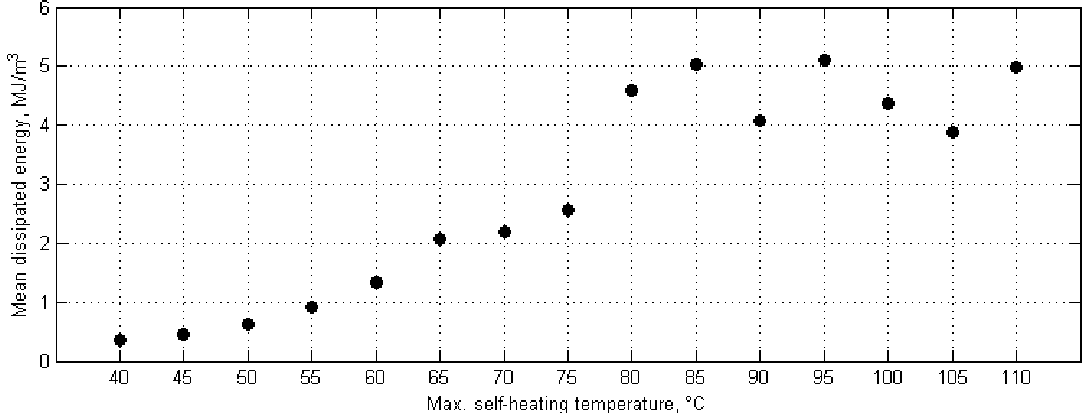
Figure 10. Amount of dissipated energy for various self-heating temperature values.